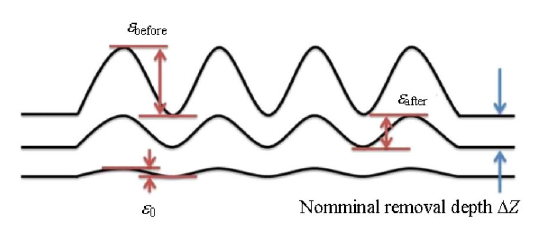
Fig. 2 Before ε before , after ε after , and final ε 0 smoothing profiles for sinusoidal error.